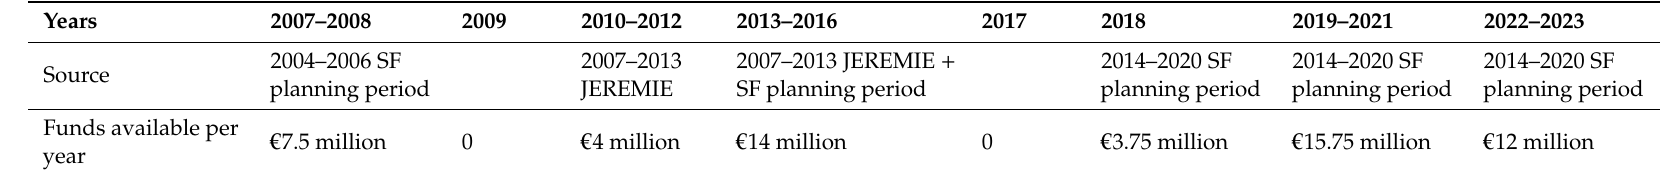
Table 3. Average public support available for VC investments in SMEs per